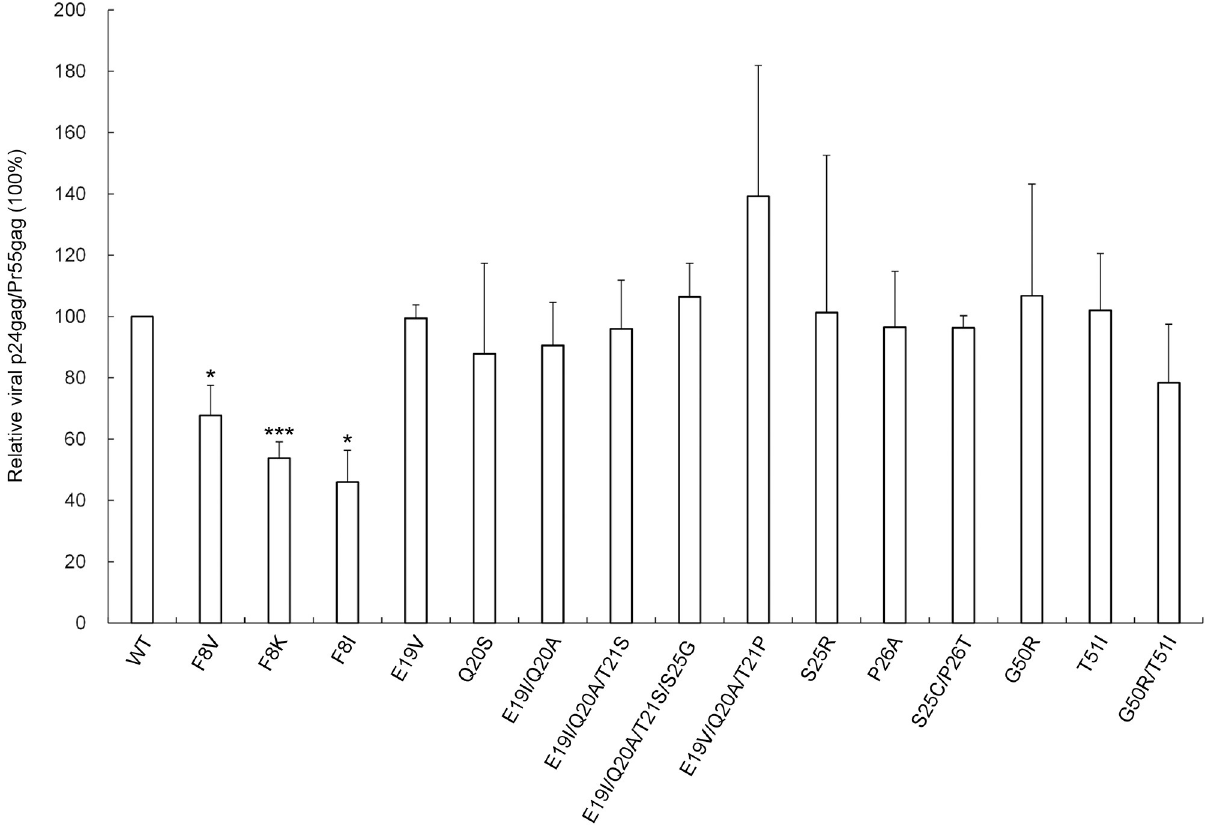
Fig 5. Virus particle processing efficiency data for p6 � mutants. Virus-associated Pr55 gag and p24 gag levels were quantified as immunoblot band densities. Ratios of p24 gag to p55 gag were determined for each mutant and normalized to those for a wt in parallel experiments. Data were obtained from three independent experiments. Error bars indicate standard deviations. � p < 0.05; ��� p <